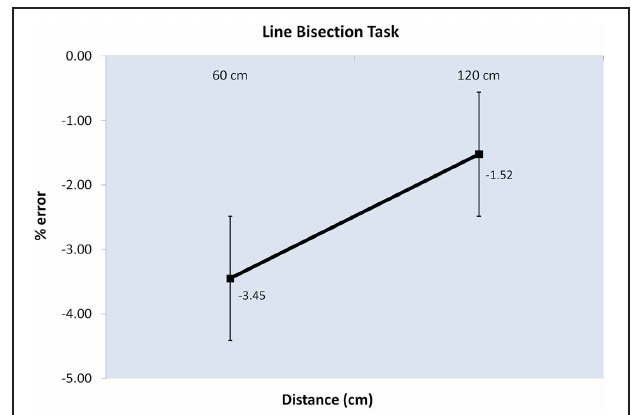
FIGURE 4 | Graph of the behavioral results. The graph shows the percentage error (Y axis) along the distances of line presentation, 60 and 120cm (X axis). Negative values indicate an error on the left of the true centre of the line; positive values indicate an error on the right of the true centre of the line. Error bars represent the standard error ±